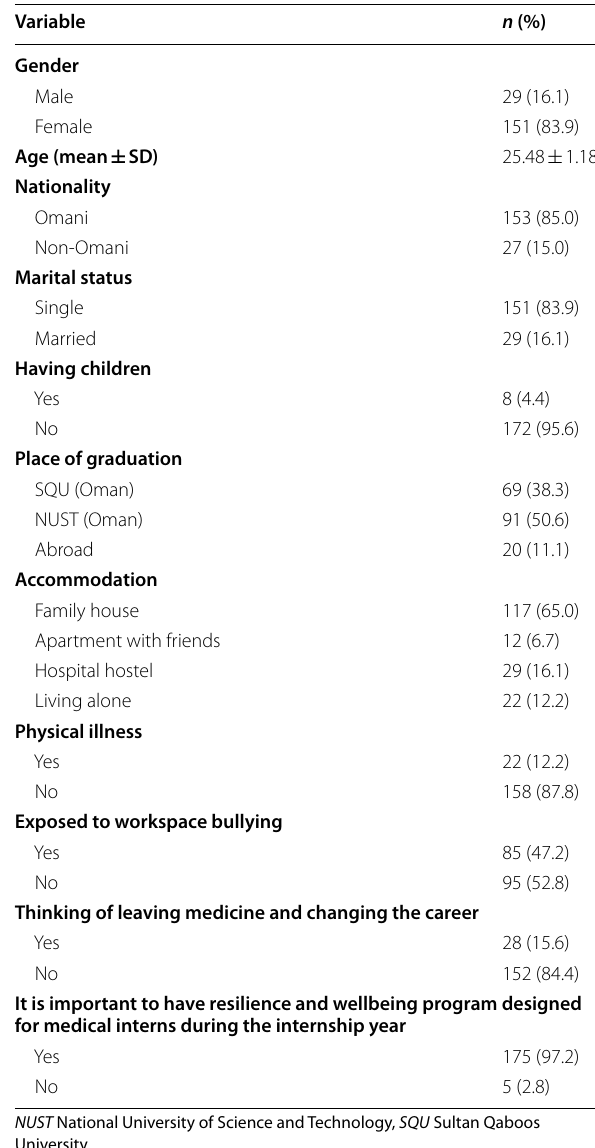
Table 1 Sociodemographics of the study participants ( N